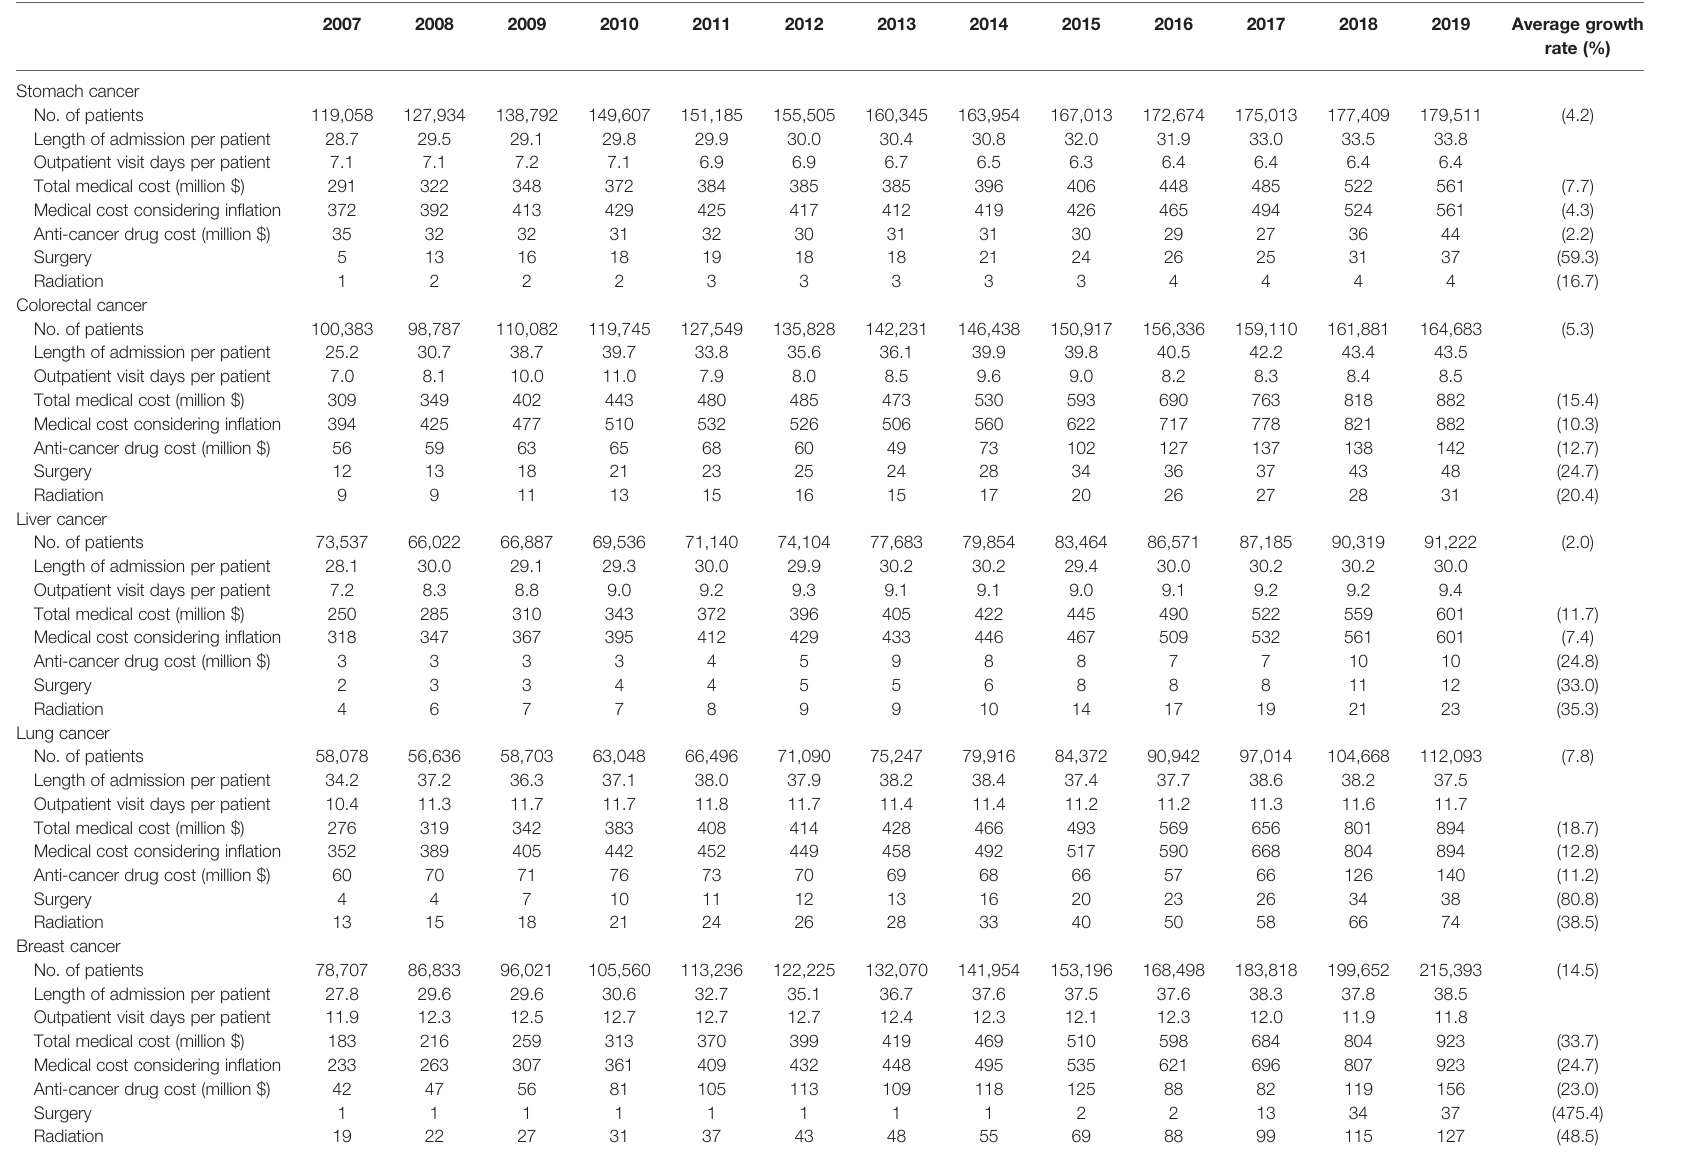
TABLE 2 | Trends in healthcare utilization and spending by cancer type and year.